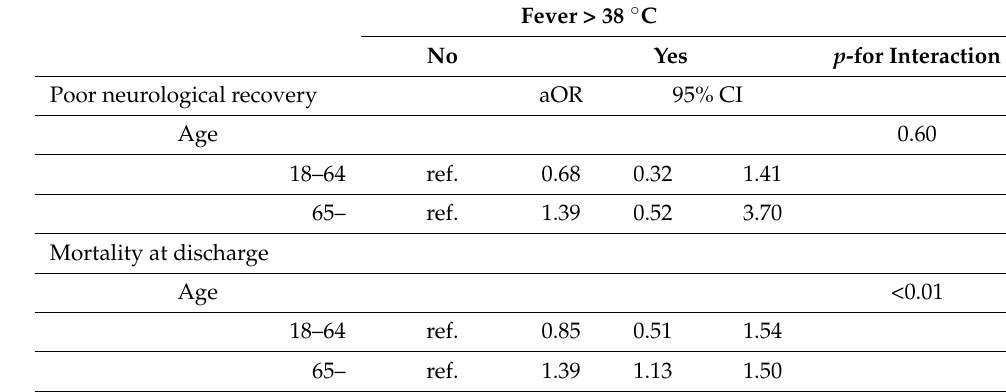
Table 4. Interaction analysis between fever and age